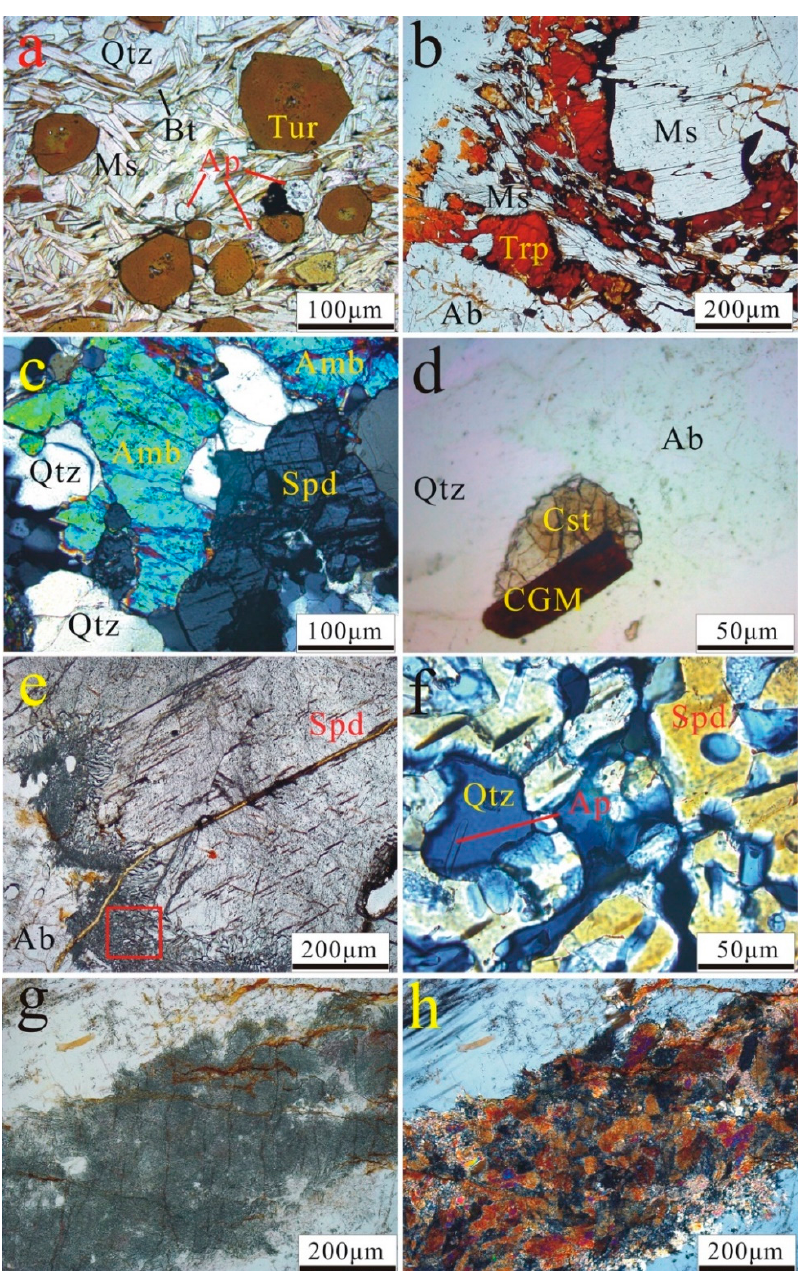
Figure 4. Photomicrographs showing typical mineralogy and textures in No. 90 pegmatite. ( a ) quartz + biotite + muscovite + tourmaline + apatite assemblage in the country rock. ( b ) red-brown triphylite-lithiophilite series (showing a dark rim of Mn-, Fe-bearing oxides) aggregates intergrown with medium-grained muscovite in the Wall Zone. ( c ) textural relationships indicating that amblygonite and spodumene were likely coeval. ( d ) coexisting columbite-group mineral and cassiterite. ( e ) the dark rim of megacrystic spodumene which is characterized by fine-grained spodumene-quartz intergrowths similar to symplectic texture. ( f ) enlargement of the red box in ( e ) showing spodumene-quartz intergrowths and acicular apatite crystals in the quartz. Photomicrographs in plane-polarized light ( g ) and in cross-polarized light ( h ) showing late-stage fine-grained spodumene aggregates in veinlets cross-cutting coarse-grained albite. Abbreviations: Qtz = quartz, Spd = spodumene, Ms = muscovite, Bt = biotite, Tur = tourmaline, Amb = amblygonite, Ap = apatite, Ab = albite, Trp = triphylite-lithiophilite series, Cst = cassiterite, and CGM = columbite-group minerals.